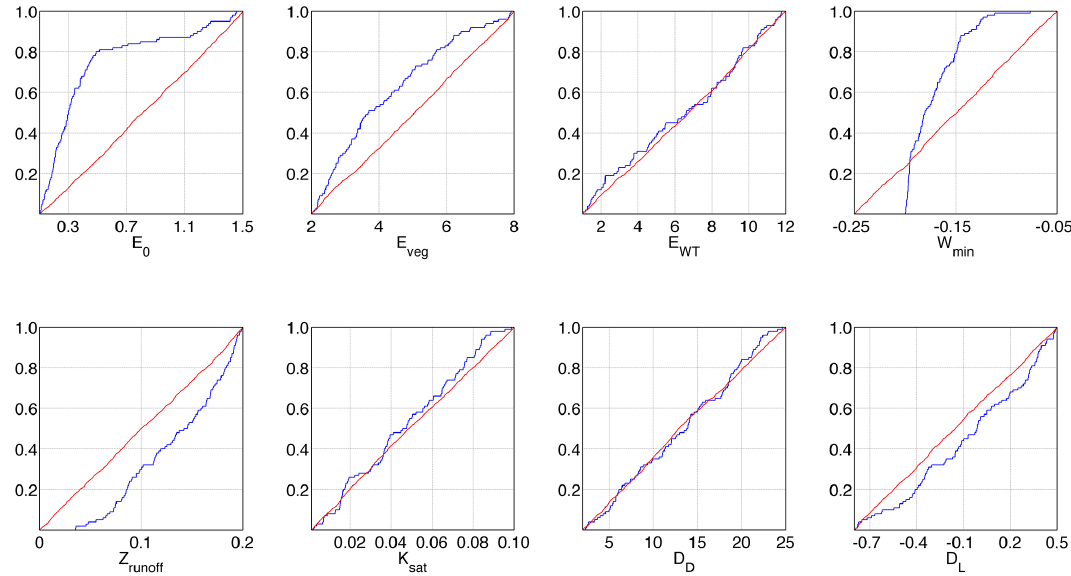
Figure 7. Deviations of cumulative distributions of parameters in hydrology module (TW1). Blue: top 100 model performance. Red: all 3000 model runs. E o , evaporation correction factor for open water; E veg , evaporation correction factor for crop/vegetation; E WT , evaporation correction factor for ground water; W min , deepest water table position; Z runoff , ponded water depth limit; K sat , horizontal saturated hydraulic conductivity; D D , downslope drainage distance; and D L , downslope drainage water level